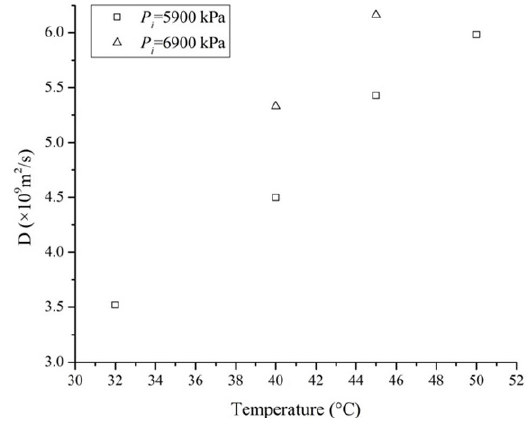
Figure 6. Effect of temperature on CO